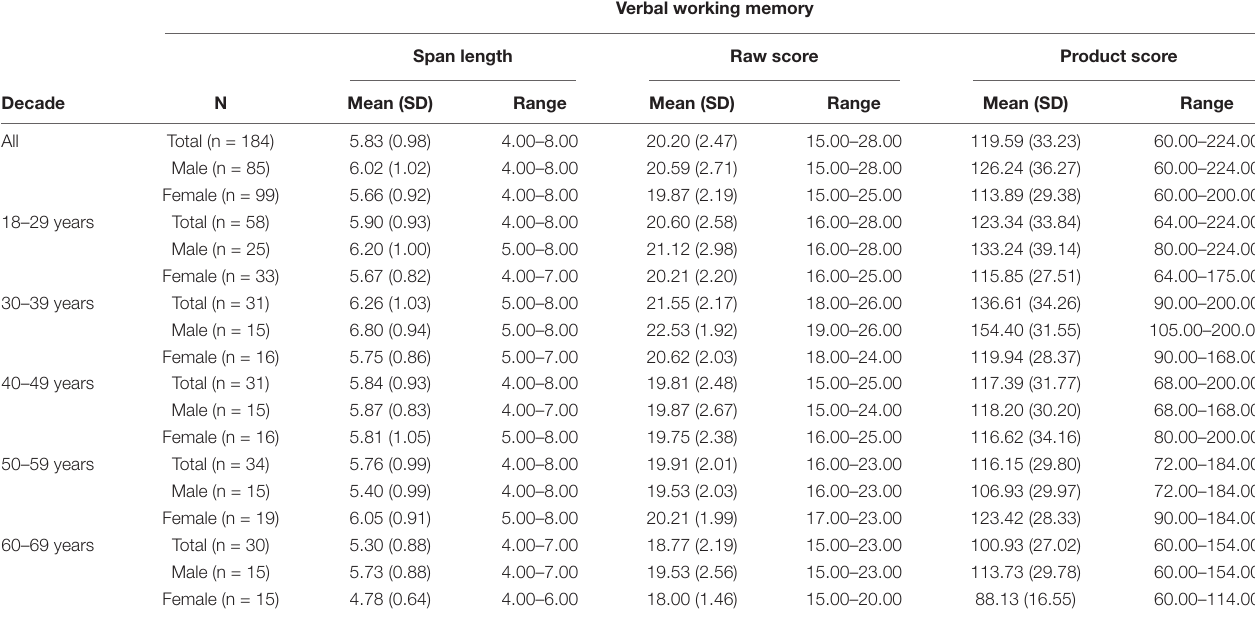
TABLE 3 | Descriptive data for the letter-number sequencing task (i.e., verbal working memory): span length (longest correctly remembered sequence, range: 2–8), raw score (number of correctly remembered trials, range: 0–30), and product score (compound score of span length and raw score, range: